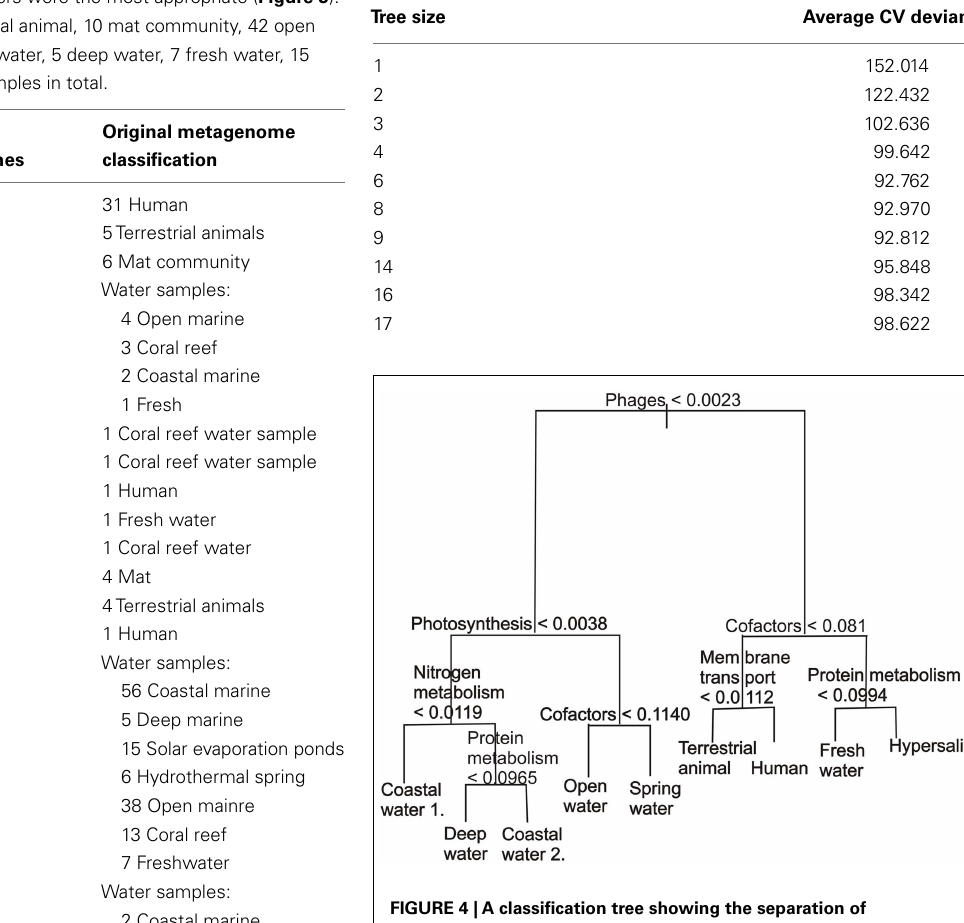
Table 2 |Tree size and average deviance from a series of tree cross-validation experiments.